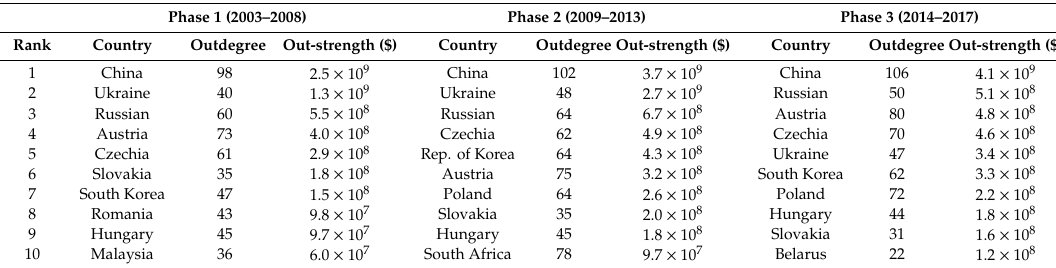
Table 3. Export of the top 10 intraregional exporters in each phase.